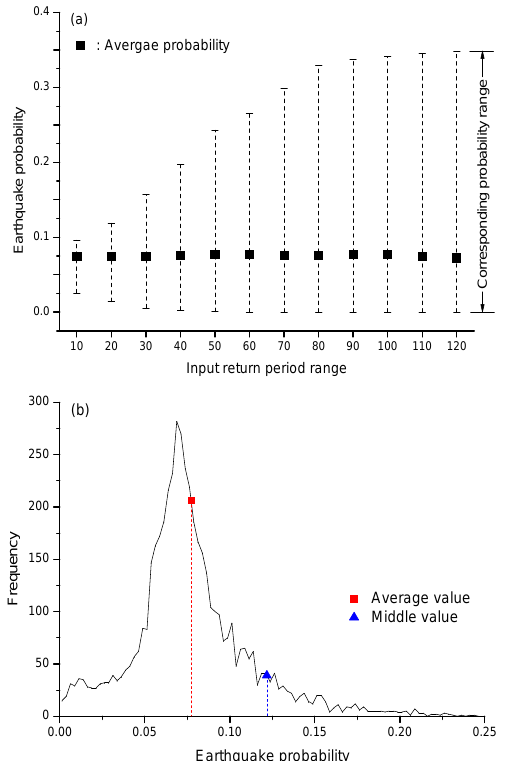
Figure 11. The result of the 12 calculations using return periods Fig. 11. The result of the 12 calculations using return periods from 162 ± 10 to 162 ± from 162 ± 10 to 162 ± 120 years: (a) the average probability and 120 years: a) the average probability and the range from the 12 MCS calculations, and the range from the 12 MCS calculations, and (b) the asymmetrical b) the asymmetrical distribution in the output data because of the non-linear distribution in the output data because of the non-linear relationship relationship between input and output in this analysis between input and output in this analysis.